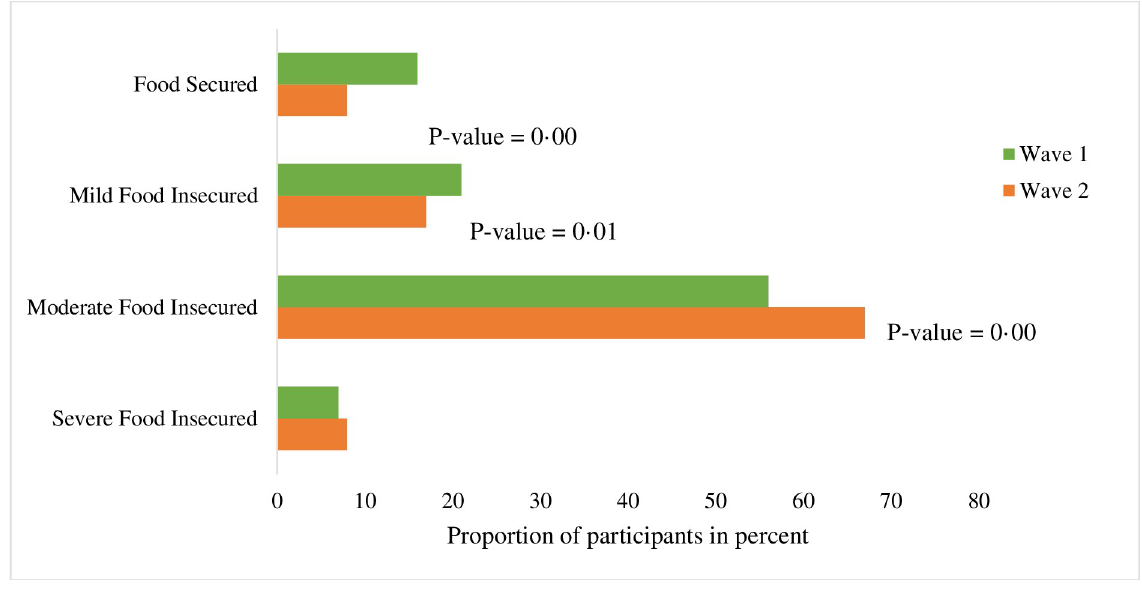
Fig 1. Food security status across wave 1 and wave 2.